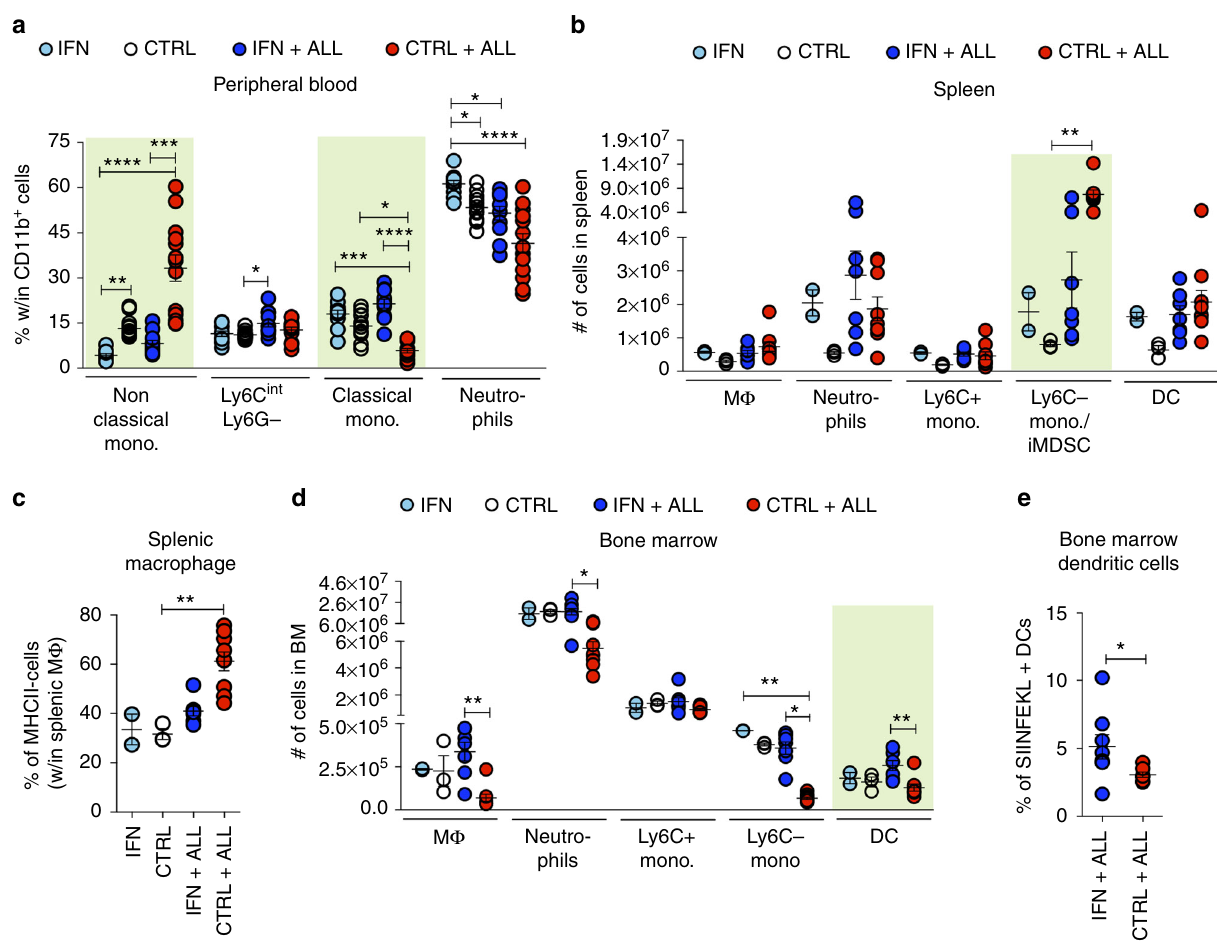
Fig. 3 IFN gene therapy imposes an immune-stimulatory program in the TME. a Percentage of the indicated populations within total myeloid cells in the PB of IFN ( n = 11) and CTRL ( n = 13) mice before and after (12 days) OVA-ALL injection. * p < 0.05, ** p < 0.01, *** p < 0.001, **** p < 0.0001, Kruskal – Wallis, with adjusted p -value by Dunn ’ s test. Statistical analysis is performed within each individual myeloid cell population. b Absolute numbers (mean± SEM) of the indicated populations in the spleen of tumor-free and OVA-ALL-injected IFN and CTRL mice (CTRL: n = 3, IFN n = 2, CTRL + ALL: n = 9, IFN + ALL: n = 7), 10 days upon tumor injection. Each dot represents a mouse. ** p < 0.01 Kruskal-Wallis with adjusted p -value by Dunn ’ s test. Statistics is performed within each individual population. c Percentage of MHC-II- macrophages present in tumor-free or tumor-bearing IFN and CTRL mice from b . ** p < 0.01, Kruskal – Wallis with adjusted p -value by Dunn ’ s test. d Absolute numbers (mean±SEM) of the indicated populations in the BM of tumor-free and OVA- ALL-injected IFN and CTRL mice from b . Each dot represents a mouse. * p < 0.05, ** p < 0.01, Kruskal – Wallis with adjusted p -value by Dunn ’ s test. Statistics is performed within each individual population. e Percentage of DCs presenting the immune-dominant OVA (SIINFEKL) peptide on MHC-I molecules in the BM of mice from CTRL + ALL ( n = 7) and IFN + ALL ( n = 8). * p < 0.05 Mann –